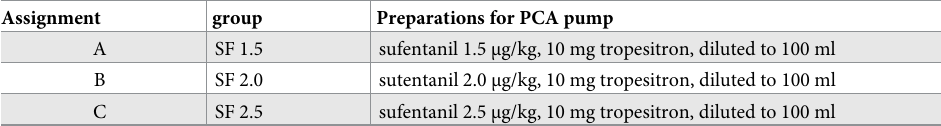
Table 1. Treatment arms.